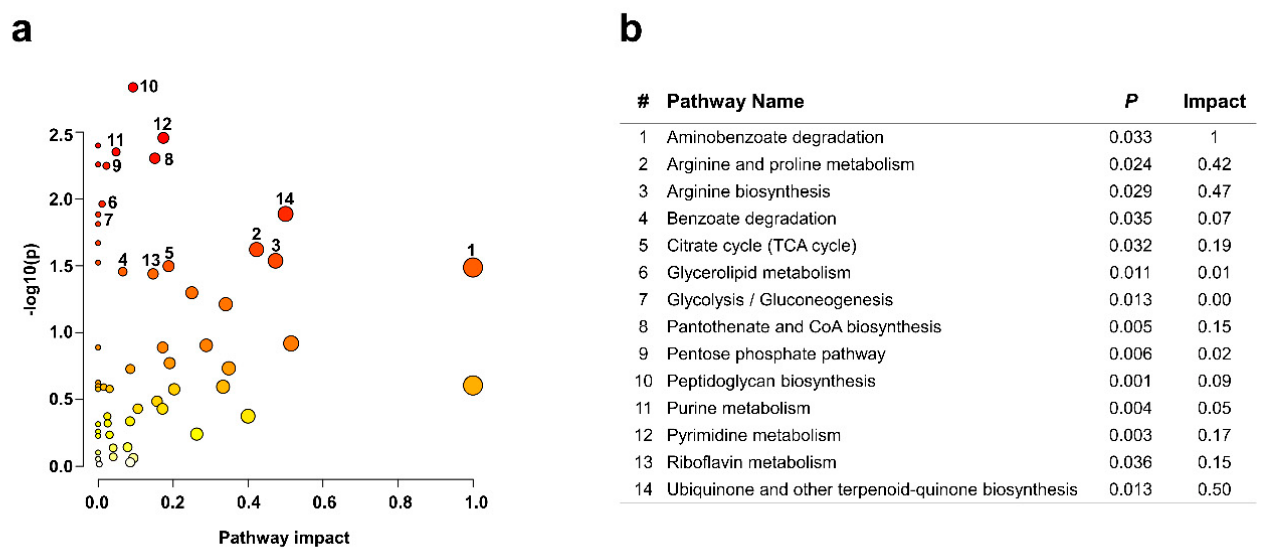
Figure 4. Metabolic pathway analysis using MetaboAnalyst 5.0. Pathway analysis was performed based on the P. putida KT2440 KEGG pathway library. ( a ) The x -axis represents the pathway impact value from pathway topology analysis, and the y -axis represents the − log p -value from pathway enrichment analysis. The node colour and radius are based on the p -value and pathway impact value, respectively. ( b ) The table represents the p -values and impact values of metabolic pathways that were significantly changed in experiments.